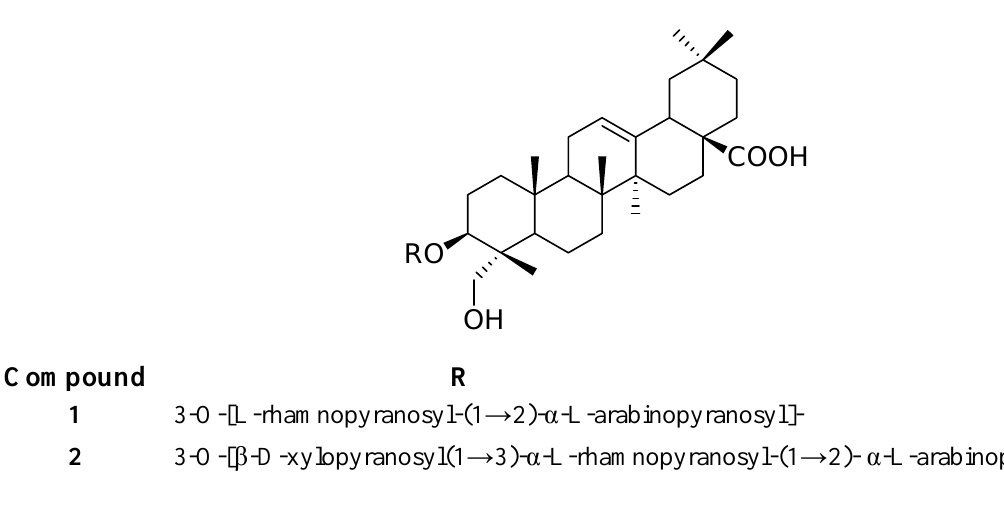
Figure 1. The structures of compounds 1 and